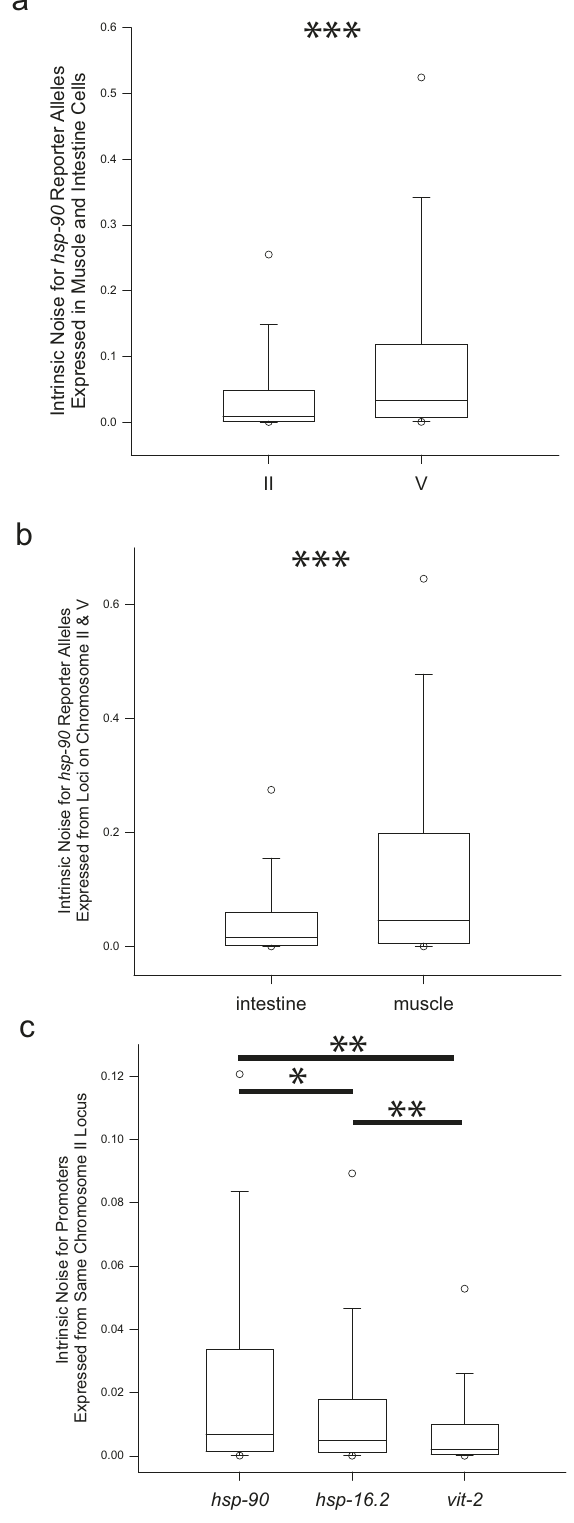
control stochastic allele bias. Figure 8 graphically summarizes the effects of introns on stochastic allele bias.